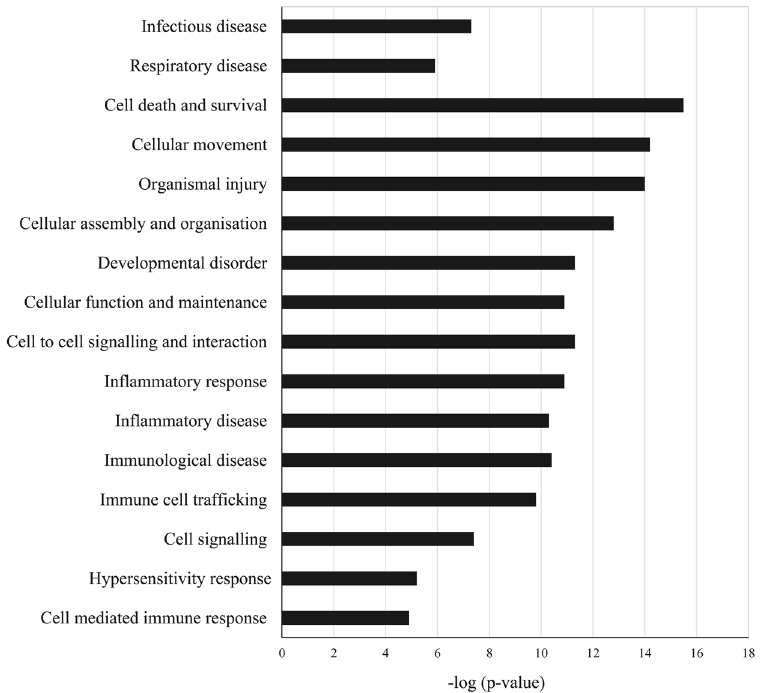
Figure 4. Biological processes in the A549 human lung epithelial cells affected by the infection with S. aurantiacum WM 06.482 conidia. Y-axis represents the biological processes and x-axis is the − log (p-value) as obtained after IPA analysis.